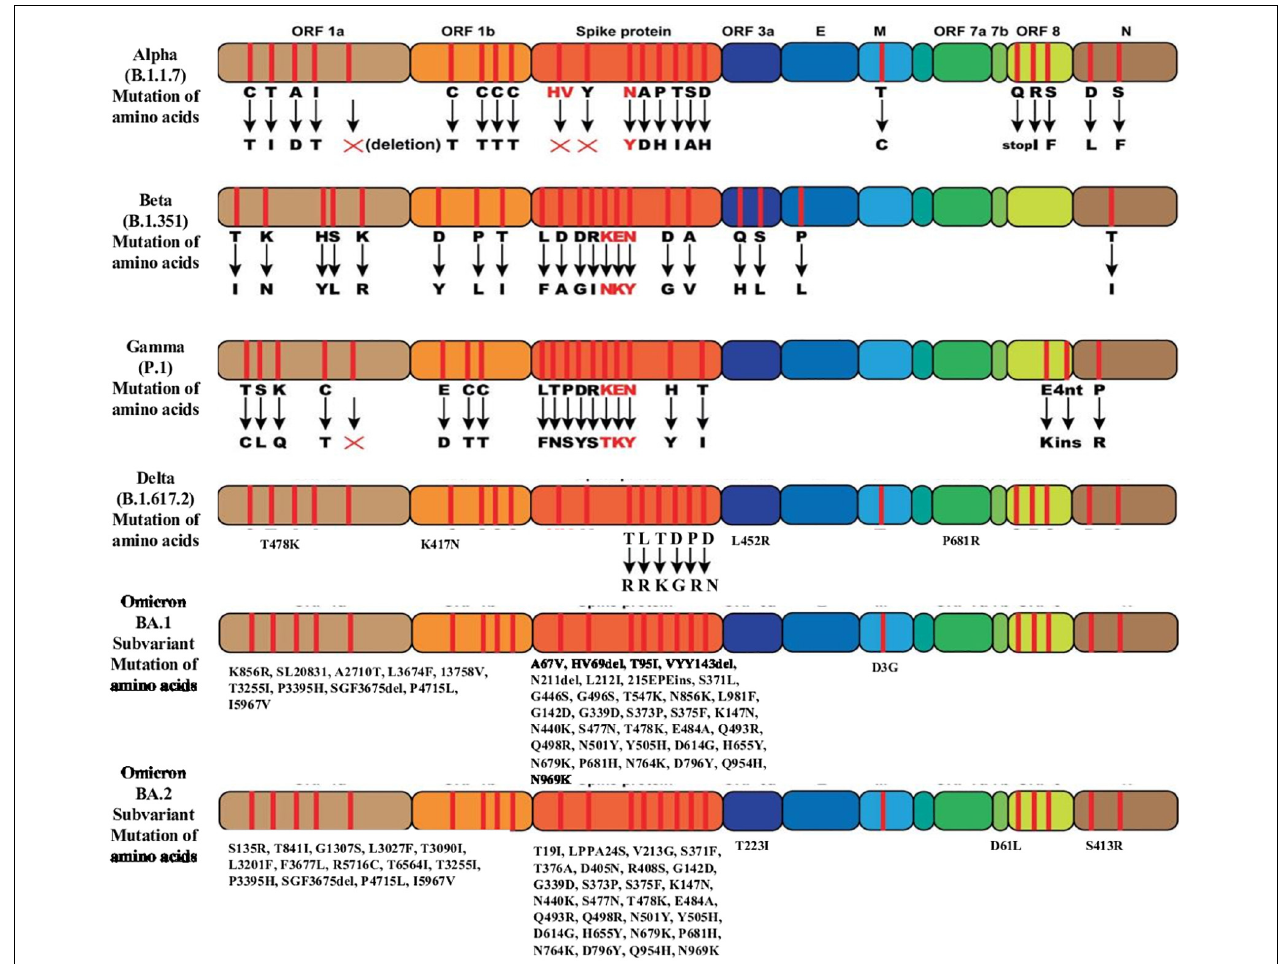
FIGURE 3 | Mutation of amino acids of the SARS-CoV-2 variants of